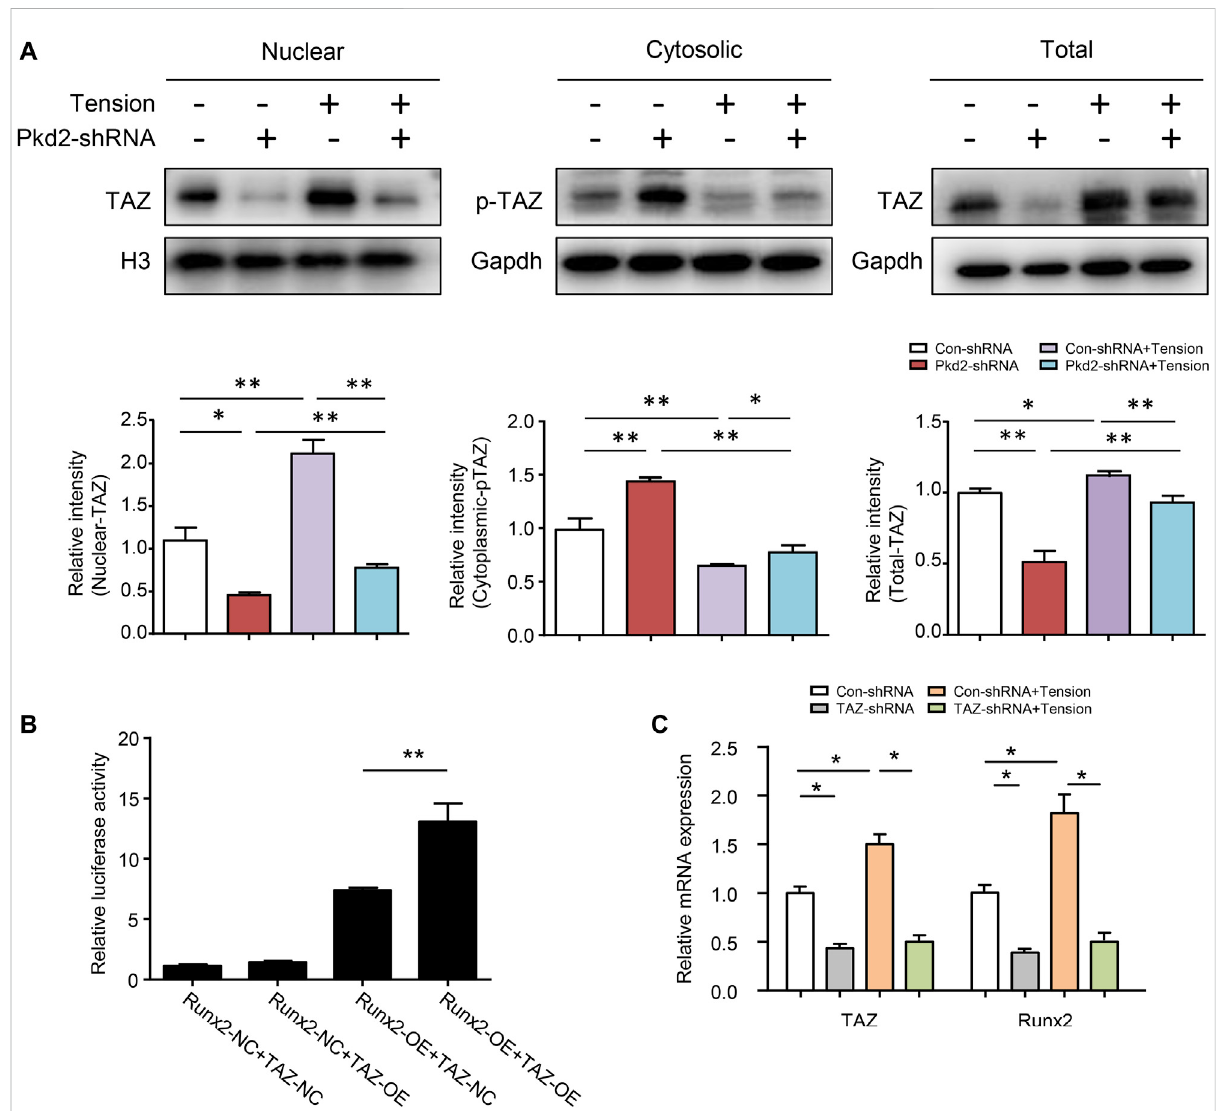
FIGURE 6 PC2 mediated mechanical tension-induced TAZ nulear translocation and osteogenic differentiation. (A) After 5-day ’ s mechanical tension, the levels of nuclear TAZ, cytosolic p-TAZ and total TAZ were examined by western blot in hASCs treated with Con-shRNA or Pkd2-shRNA. Histone H3 was used as nuclear loading control. GAPDH was used as cytosolic and total protein loading control (B) Luciferase reporter assays in 293T cells illustratedthat TAZ could bind with Runx2 atgene level (C) After 5-day ’ smechanical tension, themRNA levels of TAZ and Runx2 weredetected in hASCs treated with Con-shRNA or TAZ-shRNA. GAPDH was used for normalization. Values are the mean ± SEM. * p < 0.05, ** p < 0.01. Experiments =